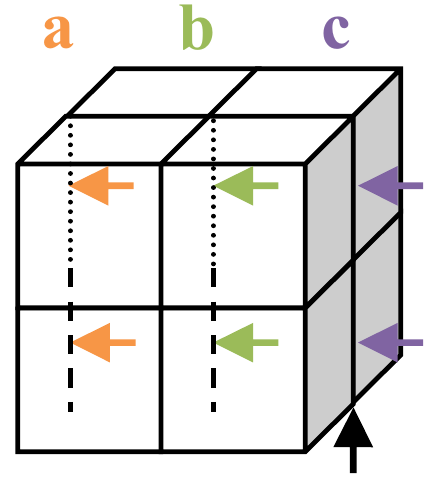
Fig. 18 Illustration of the Joint-Z joints when 2 ≤ y < b + 1